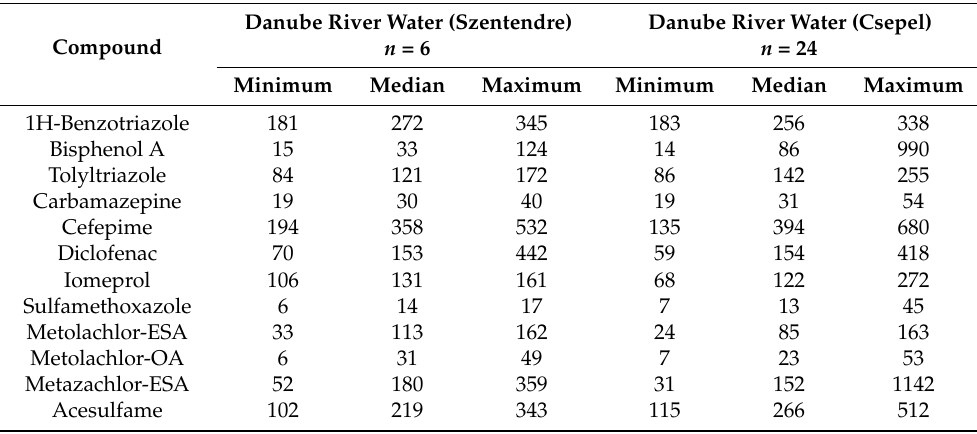
Table 2. Minimum, median, and maximum concentrations in ng/L of most prominent compounds in the Danube River Water at sampling points on Szentendre Island and Csepel